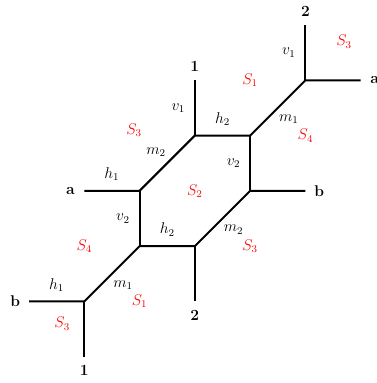
Figure 14 . Toric web diagram and parametrisation of X 2 ; 2